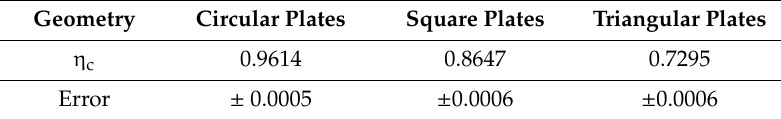
Table 1. Estimated percolation points ( η c ) for different geometries in 3D space [34]. Geometry